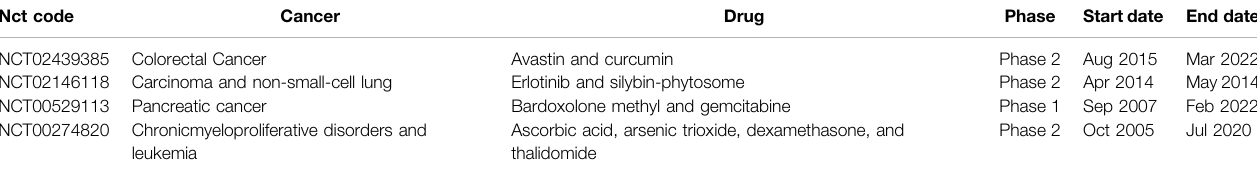
TABLE 3 | Clinical trials of molecules based on anti-angiogenic therapy against cancer in ethnopharmacology. Data from ClinicalTrials and